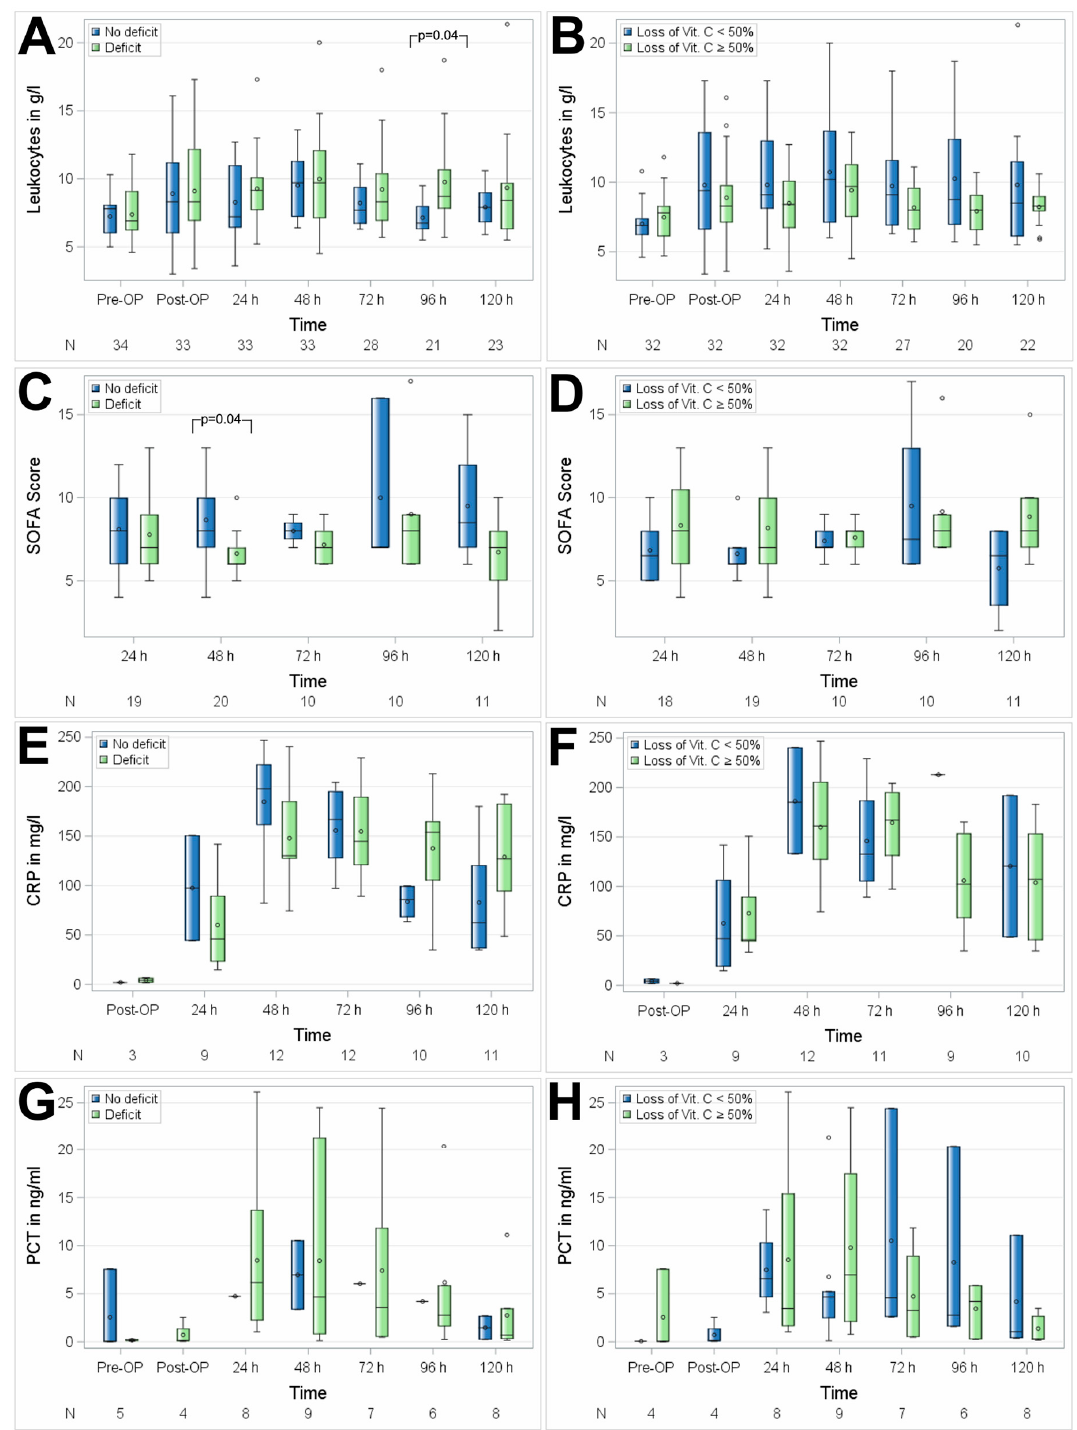
Figure 4. Association of perioperative vitamin C levels with leukocytes ( A , B ), SOFA Score ( C , D ), CRP ( E , F ), and PCT ( G , H ). N, number of patients; ( A , C , E , G ) patients with preoperative vitamin C deficit; ( B , D , F , H ) patients with intraoperative loss of vitamin C ≥ 50%. Circles represent outliers.